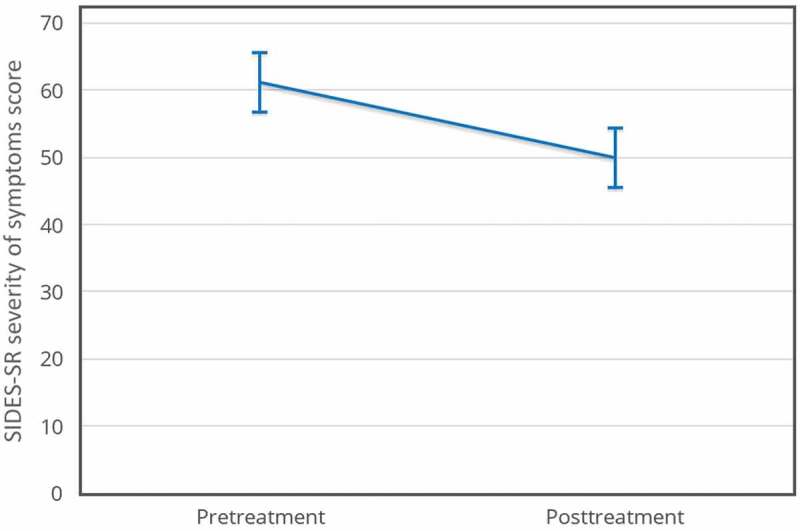
SIDES-SR severity of symptoms, N = 17.